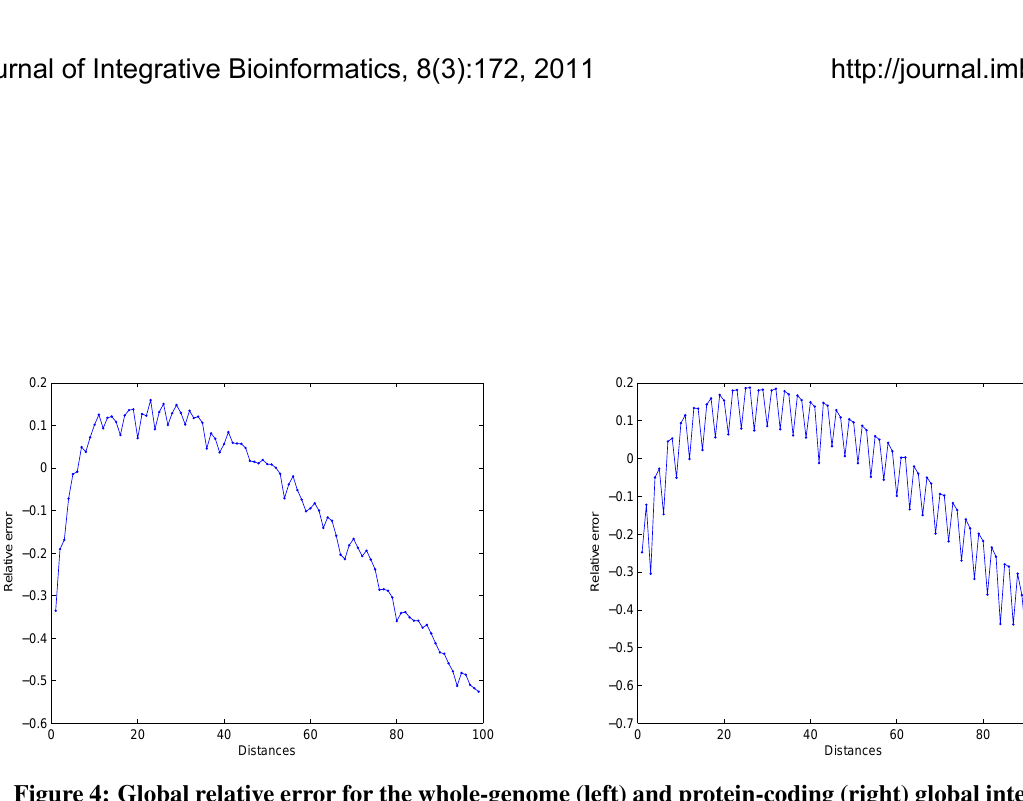
Figure 4: Global relative error for the whole-genome (left) and protein-coding (right) global inter- dinucleotide distance distributions.